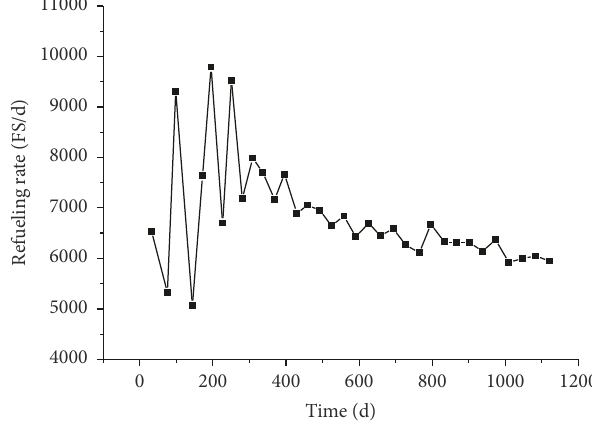
Figure 4: Refueling rate changing with time.